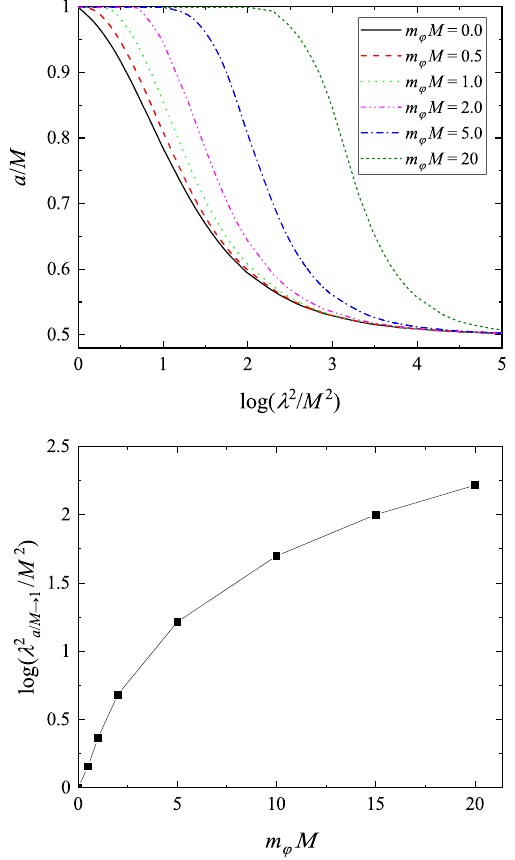
Fig. 3 ( top ) The instability lines dividing the parameter space into stable and unstable regions, for several scalar field masses m ϕ . ( bottom ) The minimum value of the Gauss–Bonnet coupling parameter, denoted / M 2 , for which the instability can develop in the a / M → 1 as λ 2 a / M → 1 limit, as a function of the scalar field